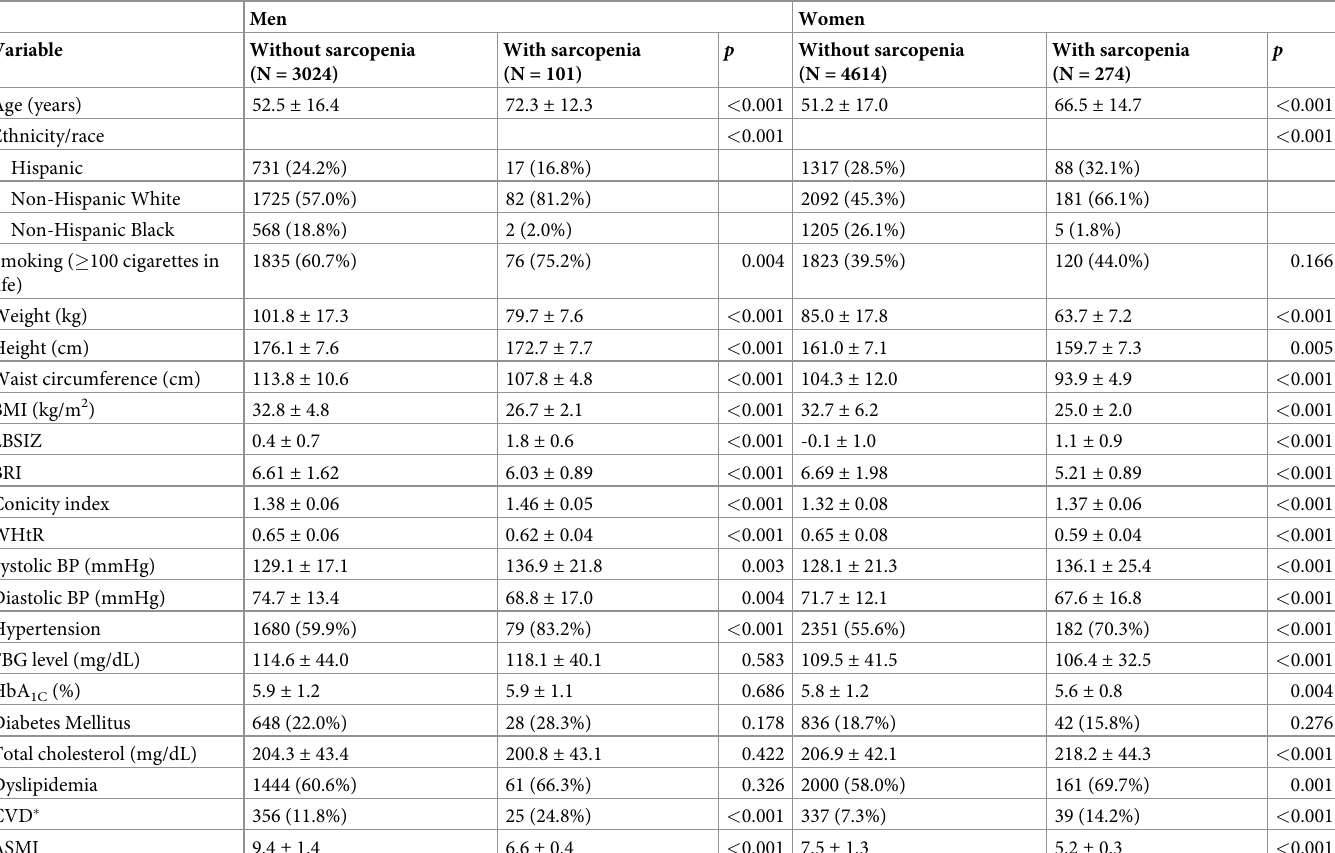
Table 1. Characteristics of the participants in US NHANES according to sex and sarcopenia.